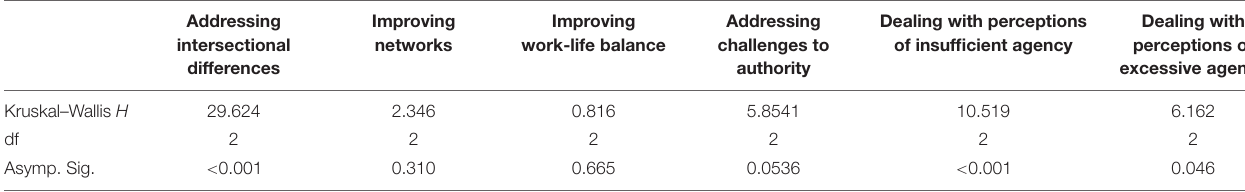
TABLE 3 | Differences in rankings of the intervention needs between racialized group.